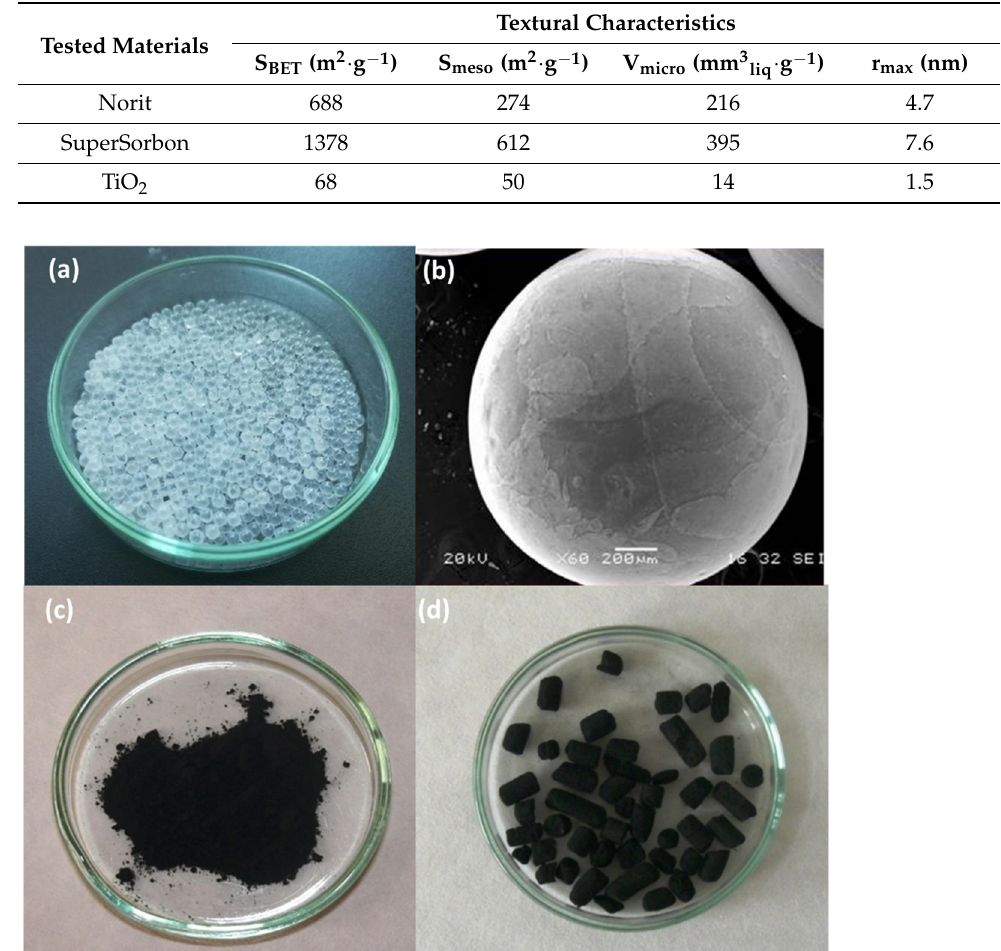
Table 1. Textural properties of sorbents and TiO 2 photocatalyst.